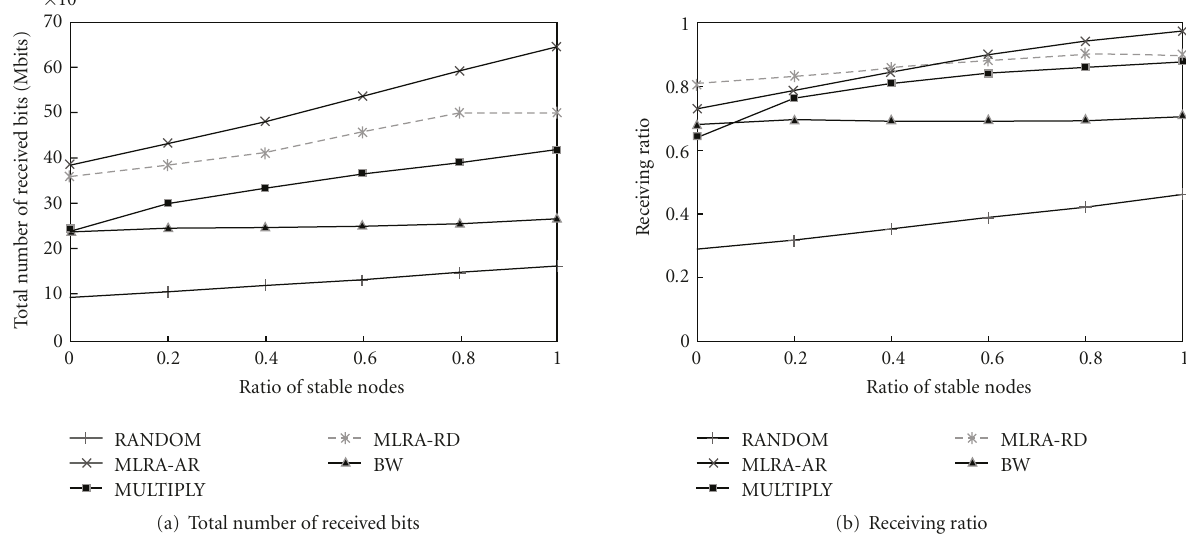
Figure 5: Performance versus ratio of stable nodes to all nodes in mTreebone with varying ratio of stable nodes. Other parameters are listed in Table